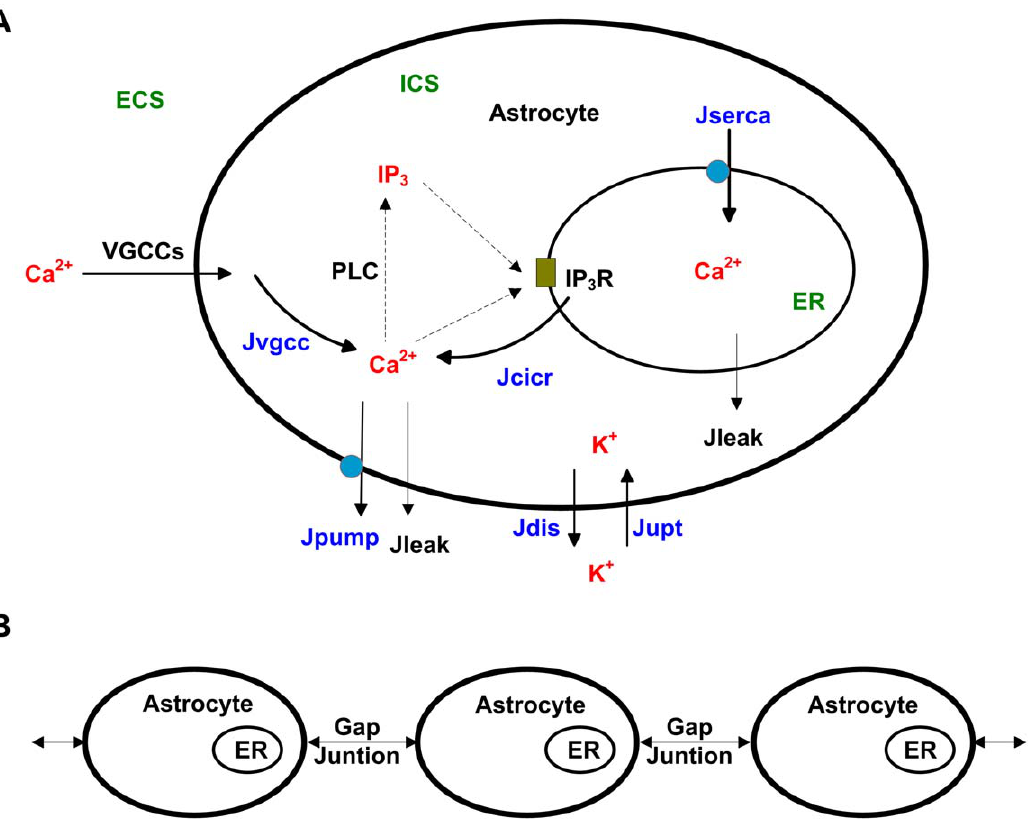
Figure 1. A schematic diagram of the model. (A) As to the single astrocyte, Ca 2 + influx through voltage-gated calcium channels (VGCCs) triggers the fluctuation of Ca 2 + in the intracellular space (ICS), enhancing the production of inositol 1,4,5-triphosphate (IP 3 ), which is catalyzed by phospholipase C (PLC). Ca 2 + and IP 3 bind to IP 3 receptors (IP 3 R), activating the process of calcium-induced calcium release (CICR). The endoplasmic reticulum (ER) is filled with Ca 2 + by the sarcoplasmic/endoplasmic reticulum calcium ATPase (SERCA). A Ca 2 + pump discharges Ca 2 + from the ICS into the extracellular space (ECS). K + in the ECS is partly uptaken into the ICS during cortical spreading depression (CSD). J VGCC , J CICR and J SERCA represent the Ca 2 + flow through VGCCs, CICR and SERCA, respectively. J pump represents the Ca 2 + flow through the Ca 2 + pump. J leak represents the leak Ca 2 + flow. J upt represents the K + flow untaken into ICS, and J dis represents the K + flow discharged into ECS. (B) Single astrocytes are coupled to the adjacent ones by the transfer of IP 3 from cytosol to cytosol through gap junctions to form a one-dimensional astrocyte network.